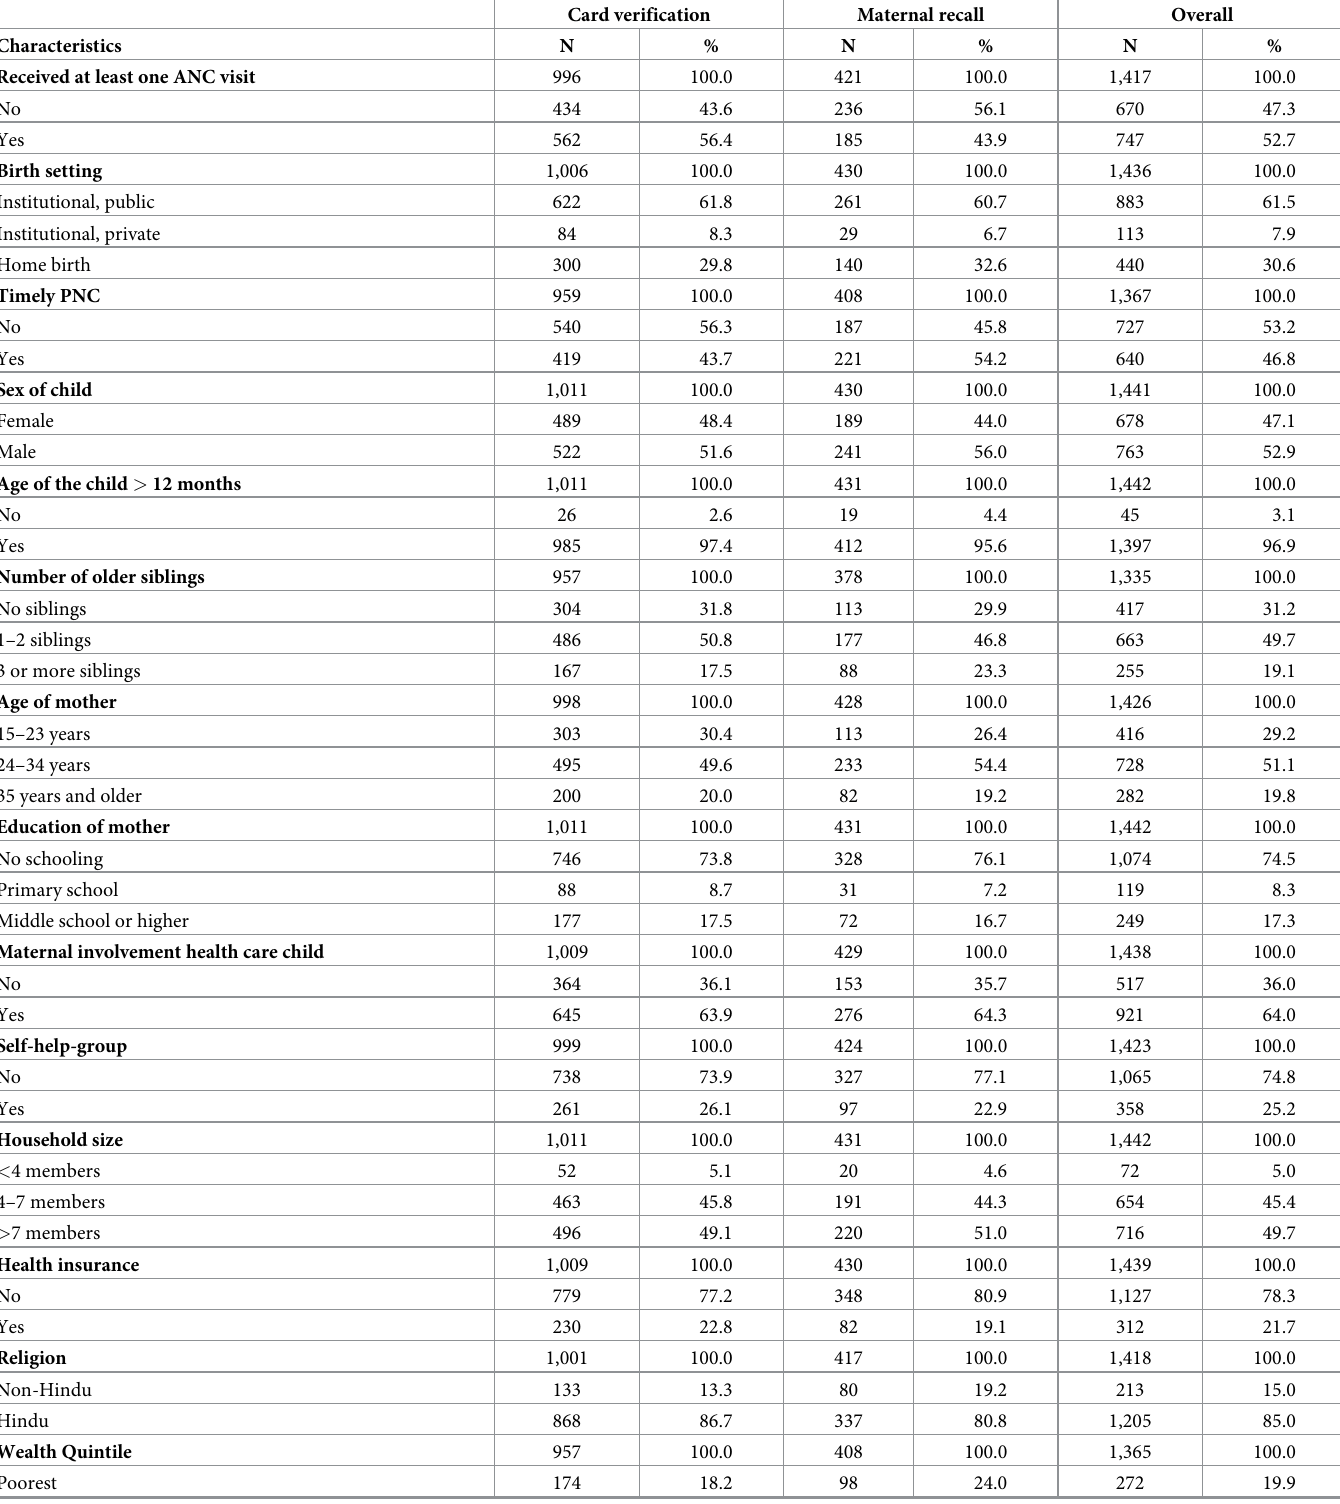
Table 2. Descriptive statistics of households according to data